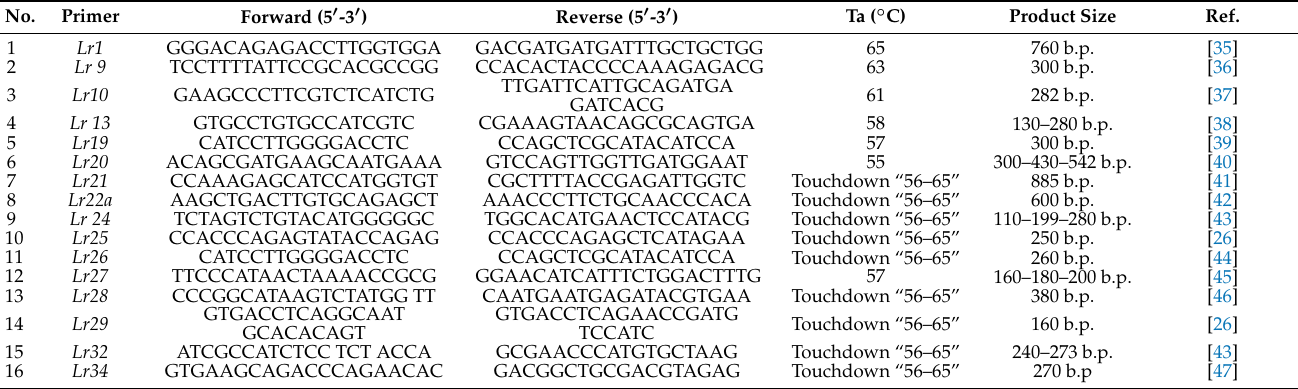
Table 3. Primer names, sequences, annealing temperature, product size, and references for Lr genes’ associated markers used in this